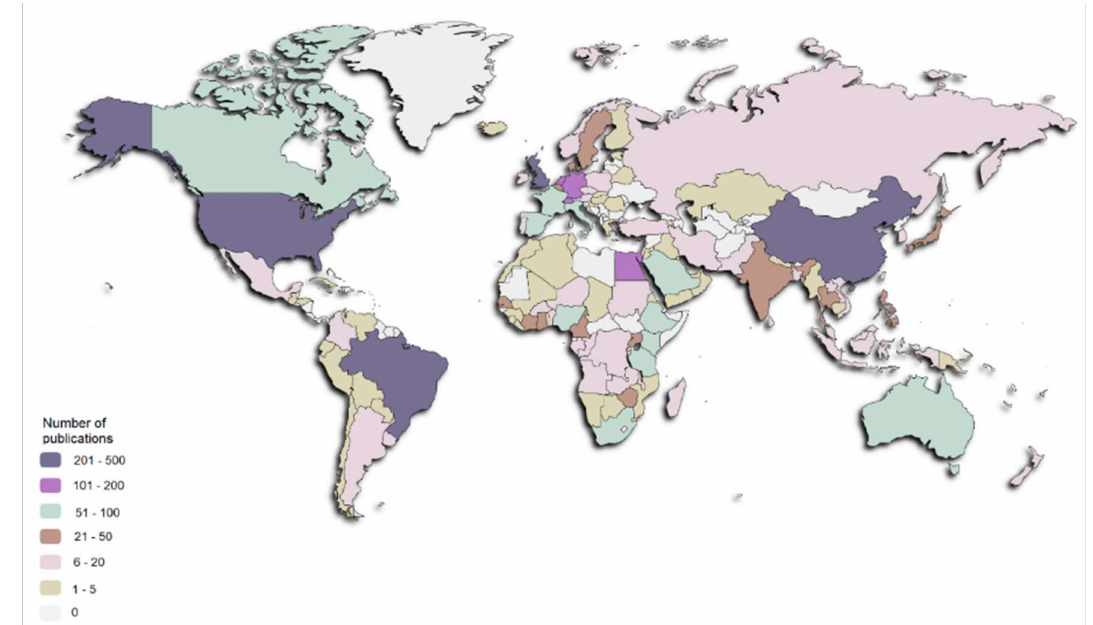
Figure 4. Global mapping of publications on